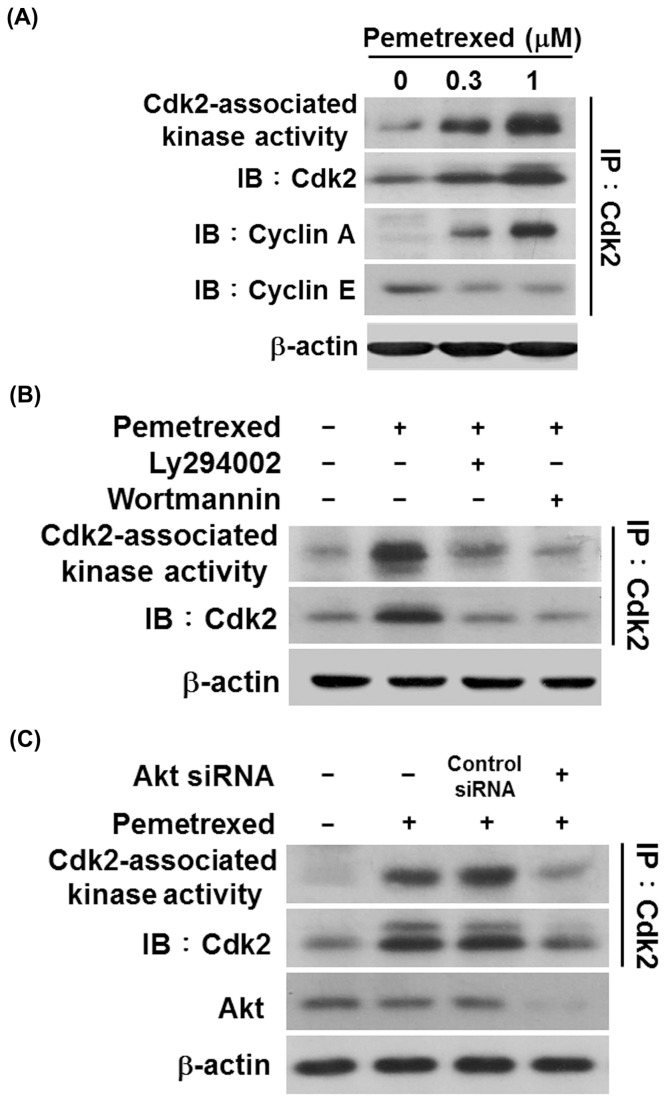
Inhibition of Akt activation suppresses pemetrexed-induced Cdk2 activation.(A) Pemetrexed stimulates Cdk2/Cyclin A-associated kinase activity. A549 cells were treated with 0, 0.3, and 1 µM pemetrexed for 24 h, and then protein lysates were isolated. Total protein (500 µg) was incubated with anti-Cdk2 antibody for immunoprecipitation of a Cdk2 kinase complex. Recombinant histone H1 protein was used as a substrate for the Cdk2 kinase activity assay. The levels of immunoprecipitated Cdk2, Cyclin A and Cyclin E were determined by immunoblotting with anti-Cdk2, anti-Cyclin A and anti-Cyclin E antibodies. β-Actin was used as an internal loading control. (B) Pharmacological inhibition of Akt activity decreases Cdk2 activity in pemetrexed-treated cells. A549 cells pretreated with 10 µM Ly294002 or 3 µM wortmannin for 2 h, and then 1 µM pemetrexed was added for another 24 h. The Cdk2 kinase activity and protein level were examined as above mentioned. (C) Knock down Akt expression by Akt specific siRNA reduces Cdk2 kinase activity. A549 cells were transfected with 25 nM of Akt-specific siRNA or scrambled siRNA for 16 h, and then incubated with 1 µM pemetrexed for 24 h, the Cdk2 kinase activity and protein levels were examined as above mentioned.